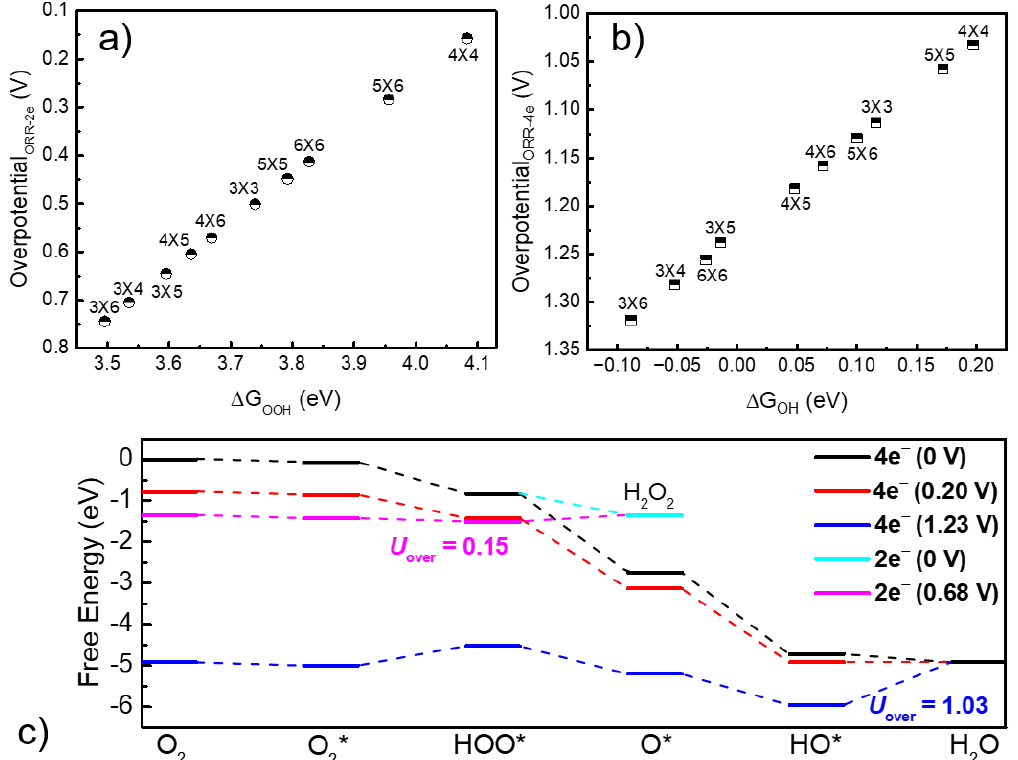
Figure 2. The catalytic activity of ORR on InN 4 surfaces in different unit cells. ( a ) The linear relationship between 2e − ORR catalytic activity and OOH adsorption free energy; ( b ) The linear relationship between 4e − ORR catalytic activity and OH adsorption free energy; ( c ) The potential energy curve of ORR process on InN 4 (4 × 4) surface.